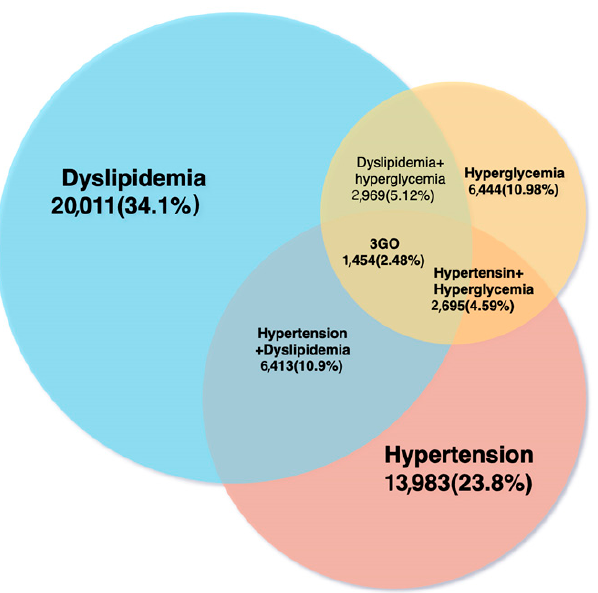
Figure 1. Numbers and percentages of participants with dyslipidemia, hypertension, or hyperglycemia. Table 1. General characteristics of the study population according to 3GO.